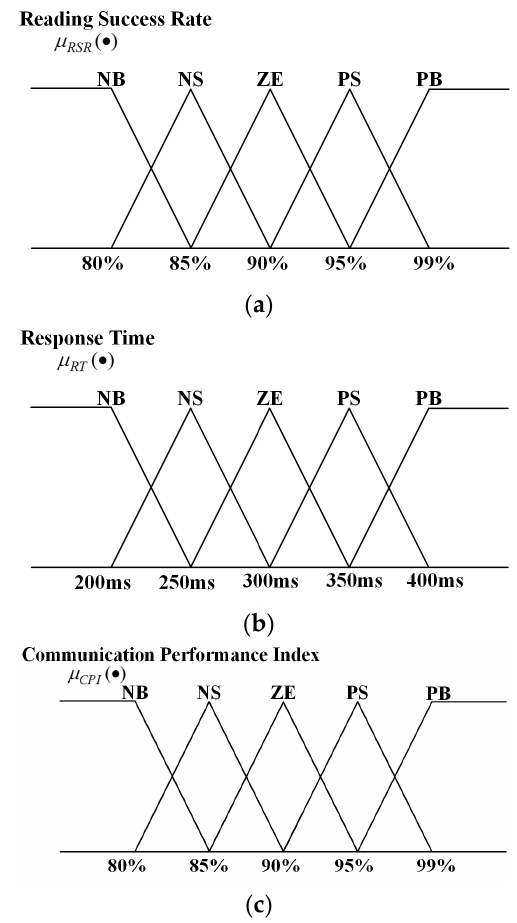
Figure 2. Membership Functions Used for Proposed CPI. ( a ) Reading Success Rate; ( b ) Response Time; ( c ) CPI.